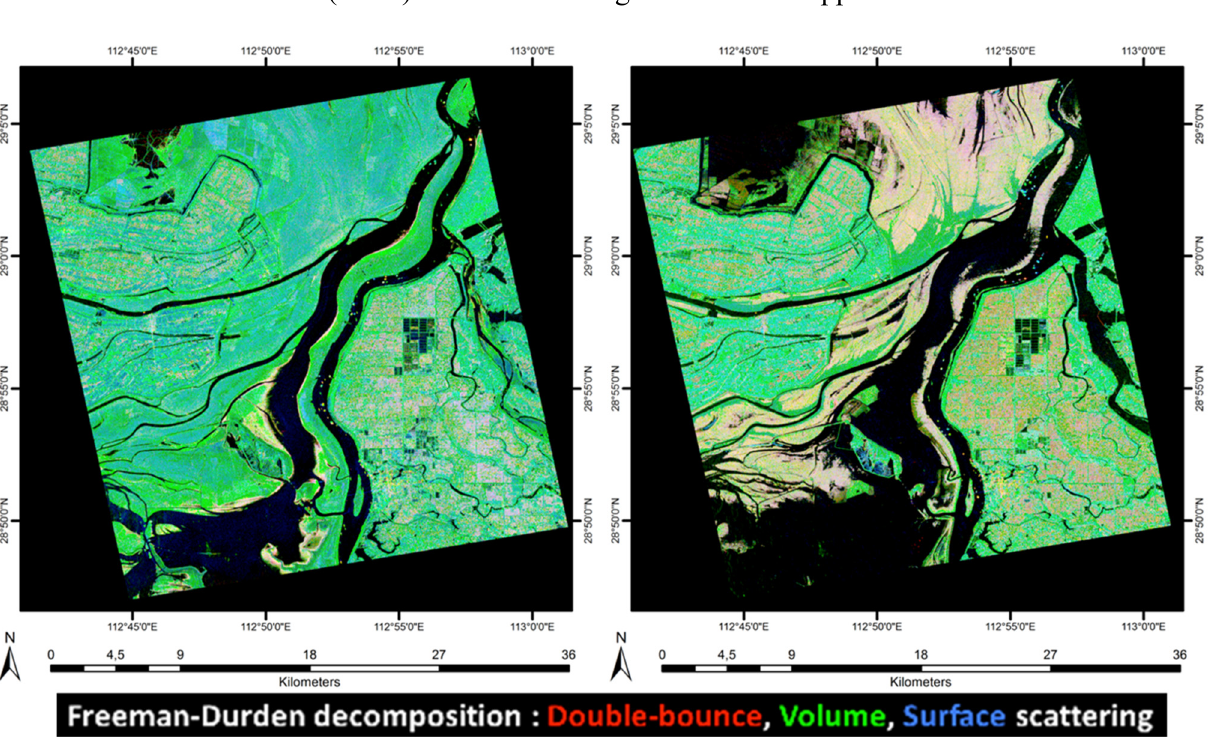
Figure 11. The Freeman-Durden decompositions derived from the 6 June 2008, and 17 August 2008, RADARSAT-2